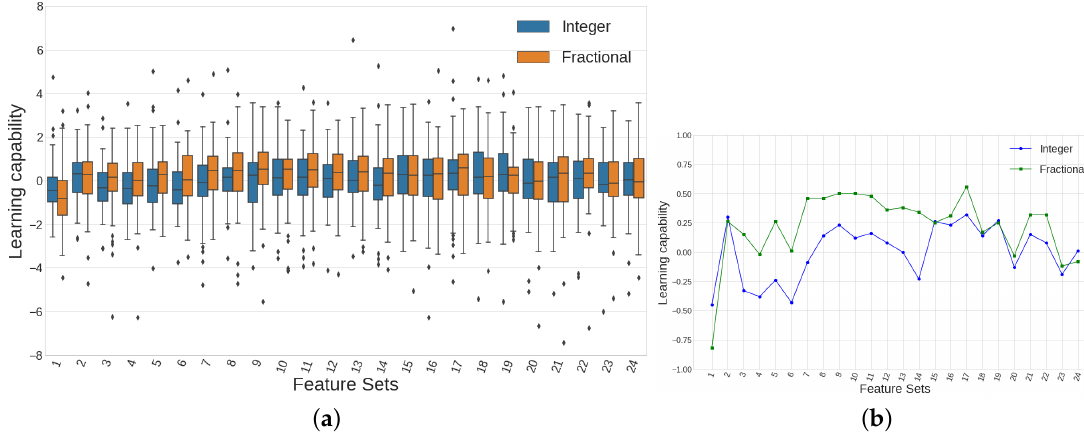
Figure 18. ( a ) Learning capability boxplots show how those distributions where fractional differences have been used, present, mostly, higher values of first, second and third quartiles. ( b ) Line plots showing median values of learning capability offer a clearer representation where it can be easily seen that 19 out of 24 feature sets using fractional differences outperform the corresponding cases that use integer differences